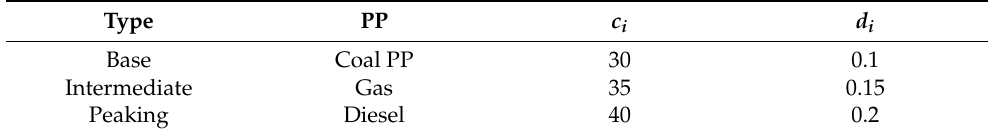
Table 1. Marginal cost function.